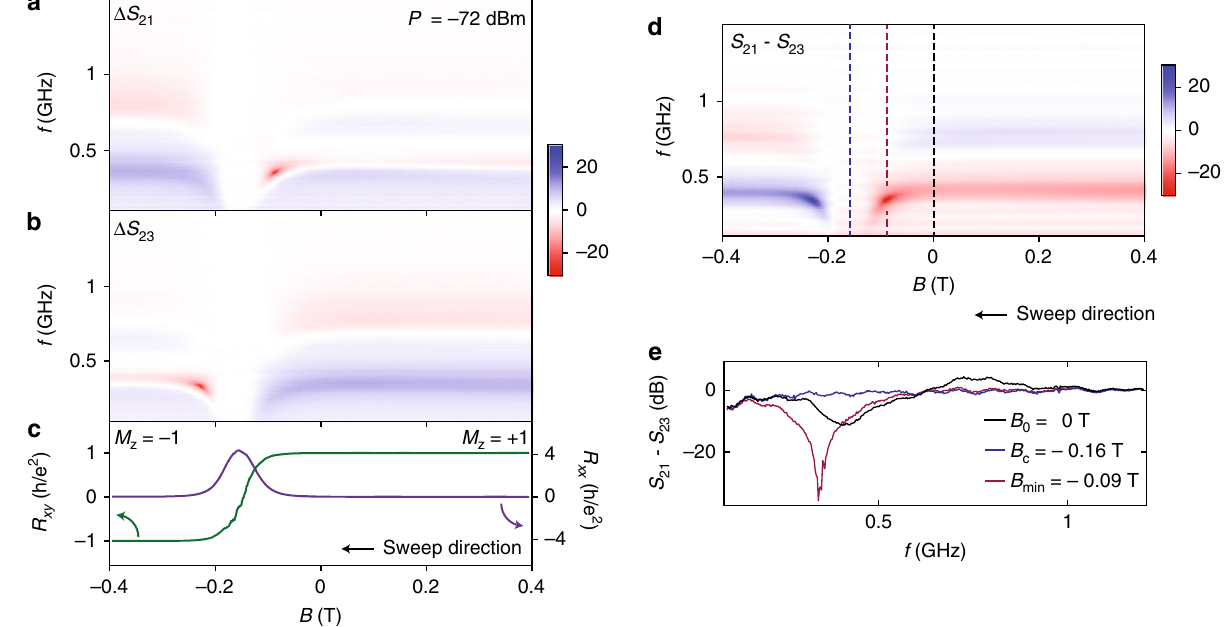
Fig. 3 Rf and dc response with magnetic fi eld. a , b Normalised Δ S 21 and Δ S 23 responses measured concurrently with the dc transport data in c . A pre- magnetisation frequency-dependent background has been subtracted from each of the traces in a , b . The colour scale represents Δ S (dB). c Transverse (green) and longitudinal (purple) resistances measured on a Hall bar as the magnetisation direction is swept from positive to negative. Away from the coercive fi eld, raw R xy approaches the resistance quantum while R xx measures ~500 Ω . In d we compare the difference between the bare S 21 and S 23 paths (indicated by the colour scale in dB), providing a measure of isolation in the system. e Line cuts through d at zero applied magnetic fi eld ( B 0 , black line), the coercive fi eld ( B c , blue) and at the point where a power minimum is observed ( B min ,